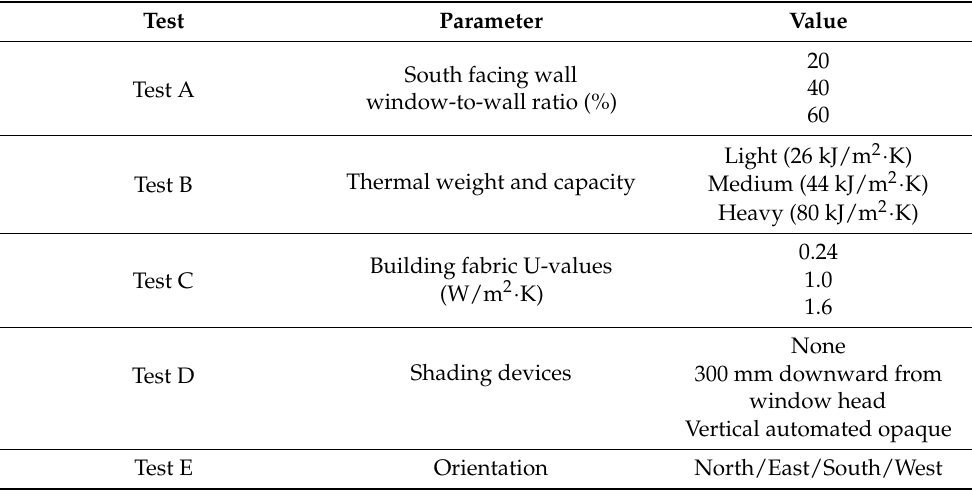
Table 4. Testing parameters for London, California, and